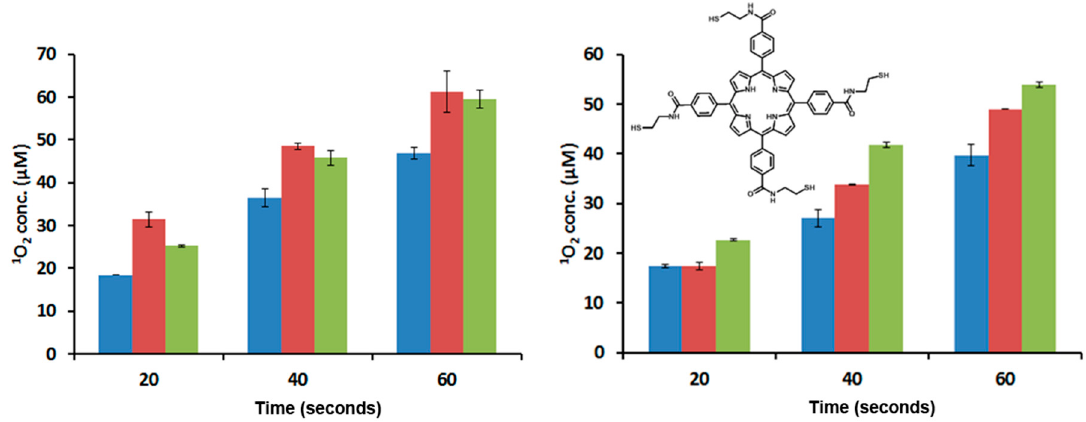
Figure 1. Determination of 1 O 2 production by compounds 2 ( blue ), 4 ( red ) and 9 ( green ) after irradiation with white ( left ) and red ( right ) light. Insert: Chemical structure of 9 . Error bars represent the standard deviation of three independent experiments.